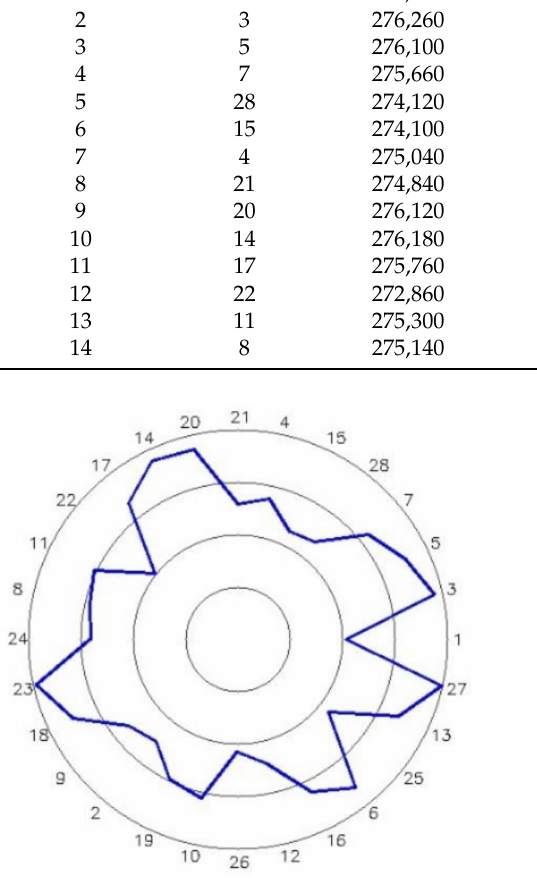
Figure 8. Installation drawing of optimal blade assembly sequence searched by IHHO. Table 4. Optimum blade assembly sequence and unbalance data for each